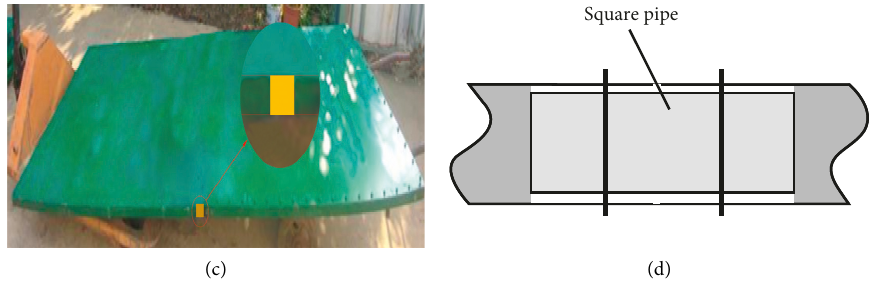
Figure 2: The adhesive and boundary holes of SPS: (a) the adhesive; (b) the holes at the boundary; (c) SPS built-in square pipe connection; and (d) square pipe connection diagram.